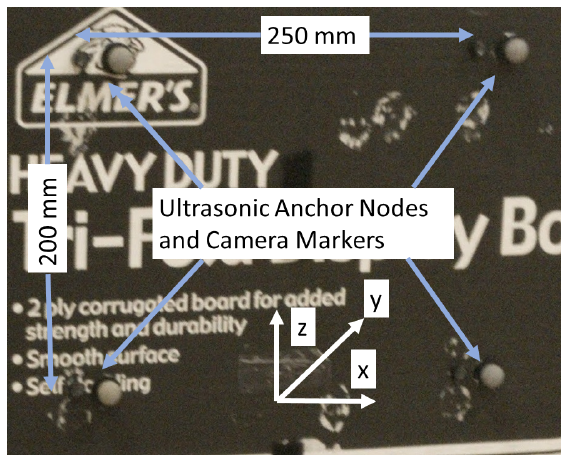
Figure 6. The anchor nodes attached on a vertical board along with the anchor